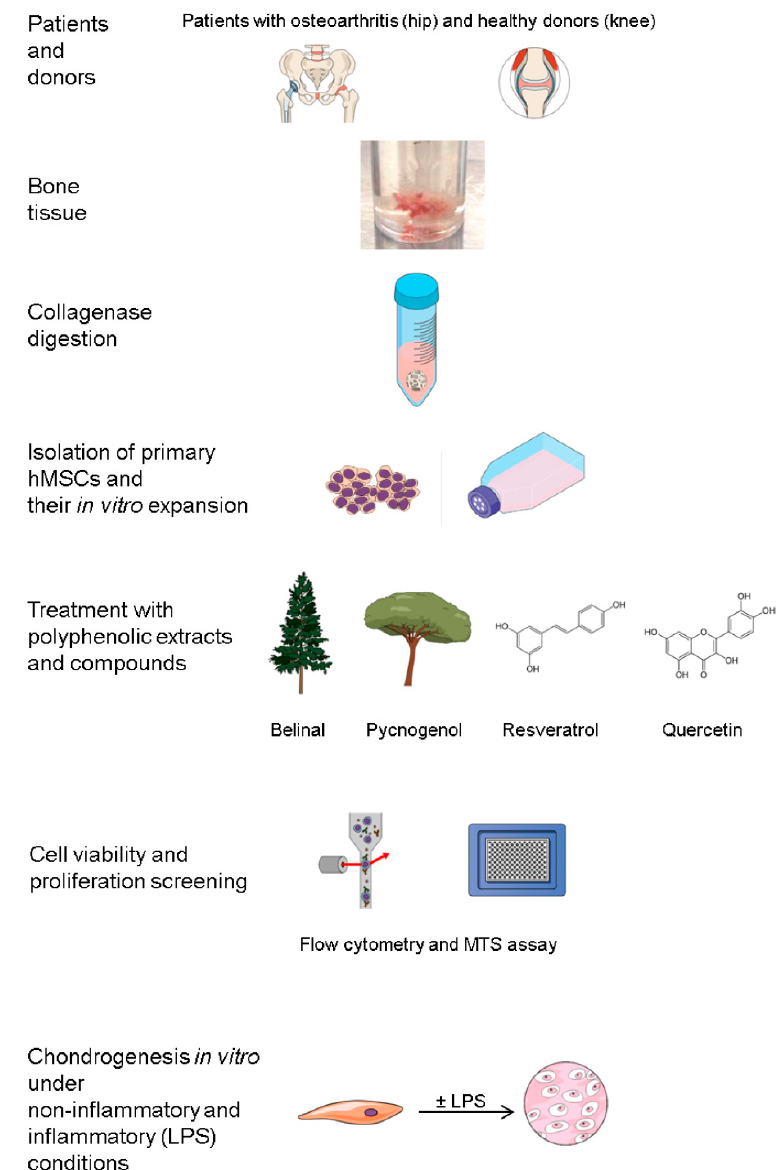
Figure 4. Study design and primary human (h)MSC samples. Primary hMSCs were isolated from